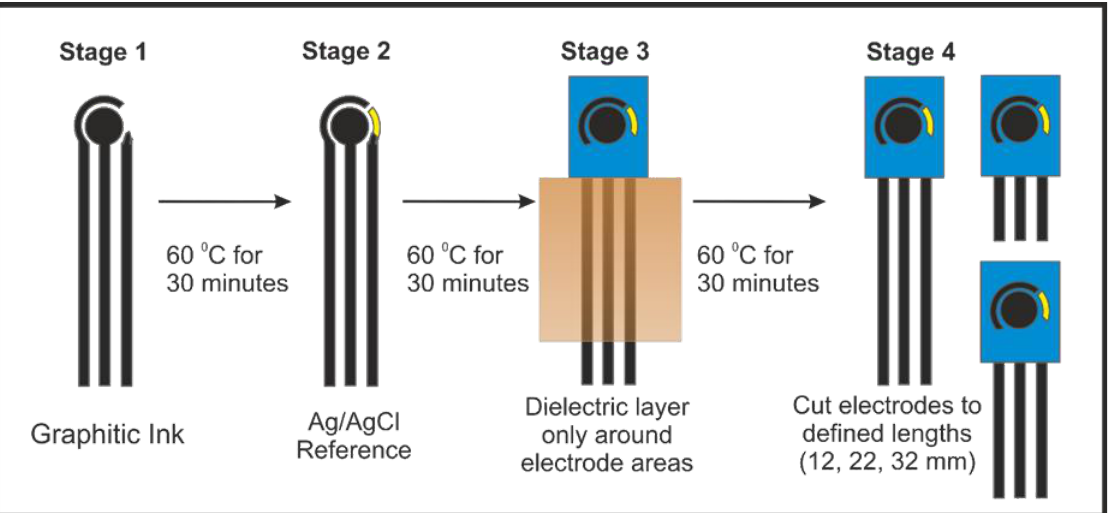
Figure 1. Schematic representation of the production of the screen-printed electrodes with various connection lengths used throughout this work. The bulk-modified SPEs had an additional working electrode layer printed, using the same graphitic ink modified with 10% (w/w) catalyst before being dried at 60°C for 30 min. Reproduced with permission from ref. [21]. Copyright 2021 American Chemical Society (ACS).